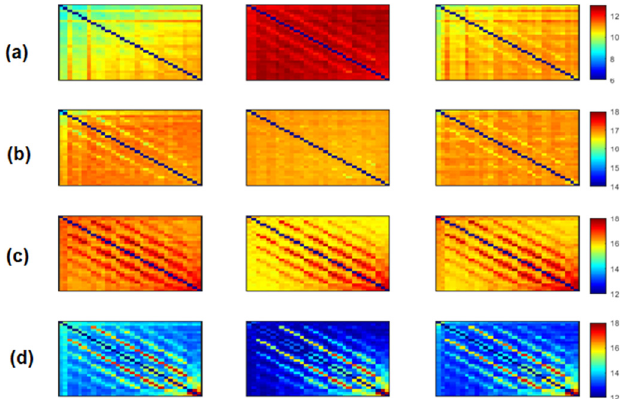
Figure 4. Average EpEn across subjects in the SCI (left), MCI (middle) and AD (right) groups for the ( a ) delta, ( b ) theta, ( c ) alpha and ( d ) beta bands. The 30 electrodes are shown from left to right side, anterior-posteriorly (up to bottom). The color bar indicates the values of EpEn.